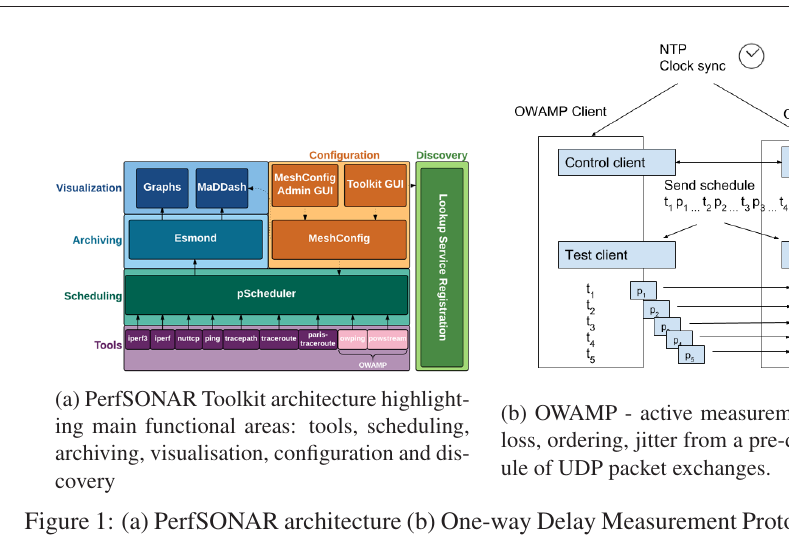
Figure 1: (a) PerfSONAR architecture (b) One-way Delay Measurement Protocol